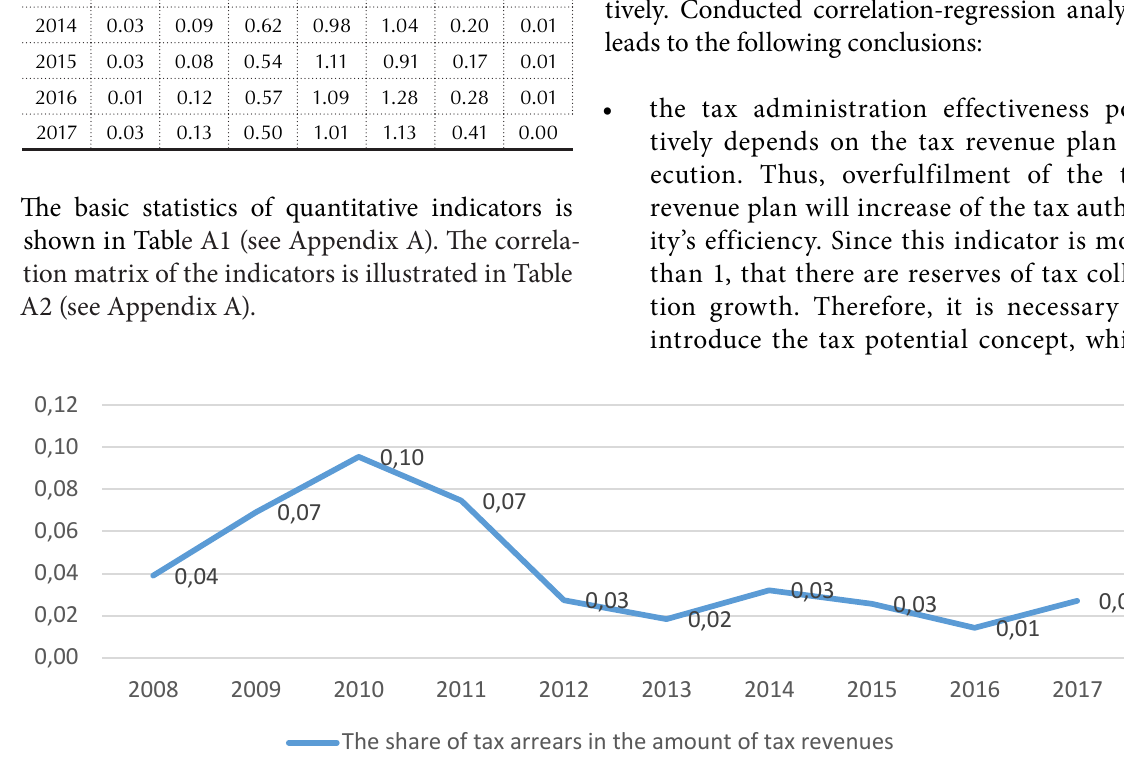
Figure 2. Dynamics of the share of tax arrears in the amount of tax revenues of the